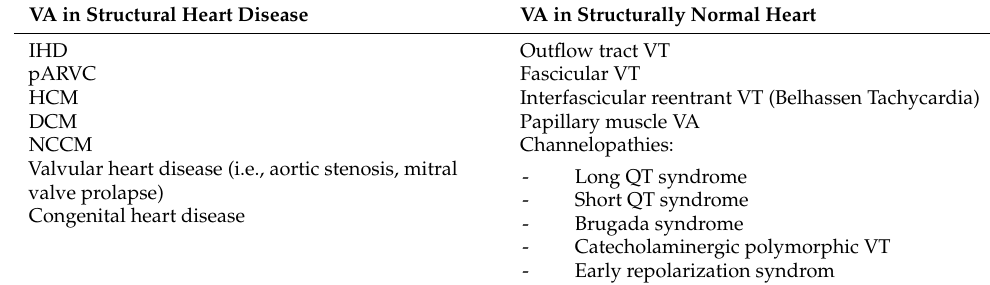
Table 2. Etiology of